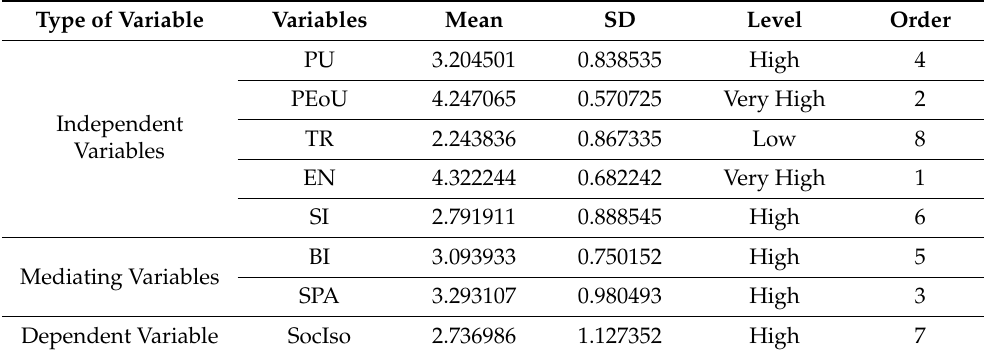
Table 3. Overall mean and standard deviation of the study’s